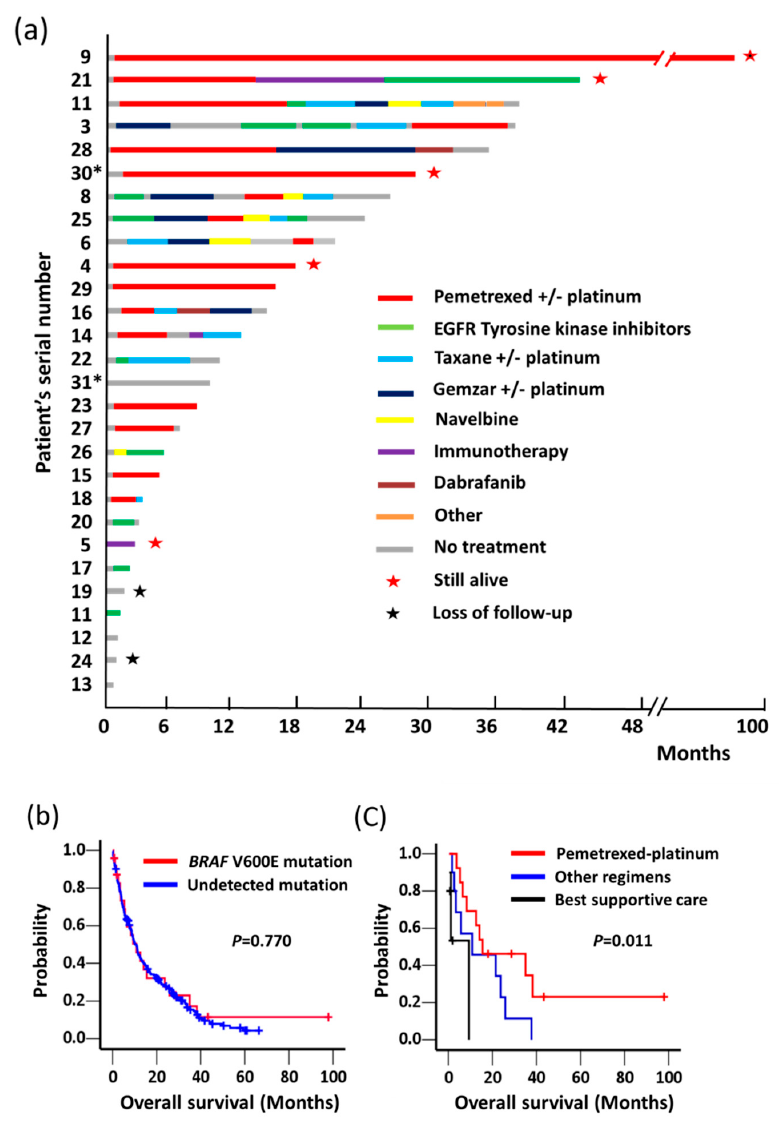
Figure 3. ( a ) The duration of treatments with chemotherapy, targeted and non-targeted therapies, or immunotherapy for patients with metastatic BRAF V600E-mutant lung cancers. Symbol with “*” indicates no available tissue sample for BRAF VE1 immunohistochemistry analysis. ( b ) Kaplan–Meier curves of overall survival in patients with lung adenocarcinoma carrying BRAF V600E mutation ( n = 24) and non- BRAF V600E with undetected mutation ( n = 223). ( c ) Kaplan–Meier curves of overall survival in Stage IV BRAF V600E-mutated patients who received first-line therapy pemetrexed/platinum then maintenance pemetrexed ( n = 13), other treatment regimens ( n = 10), or best supportive care ( n = 5). p - values were calculated using a log-rank test. Symbols with “+” on the plot indicate censored patients.